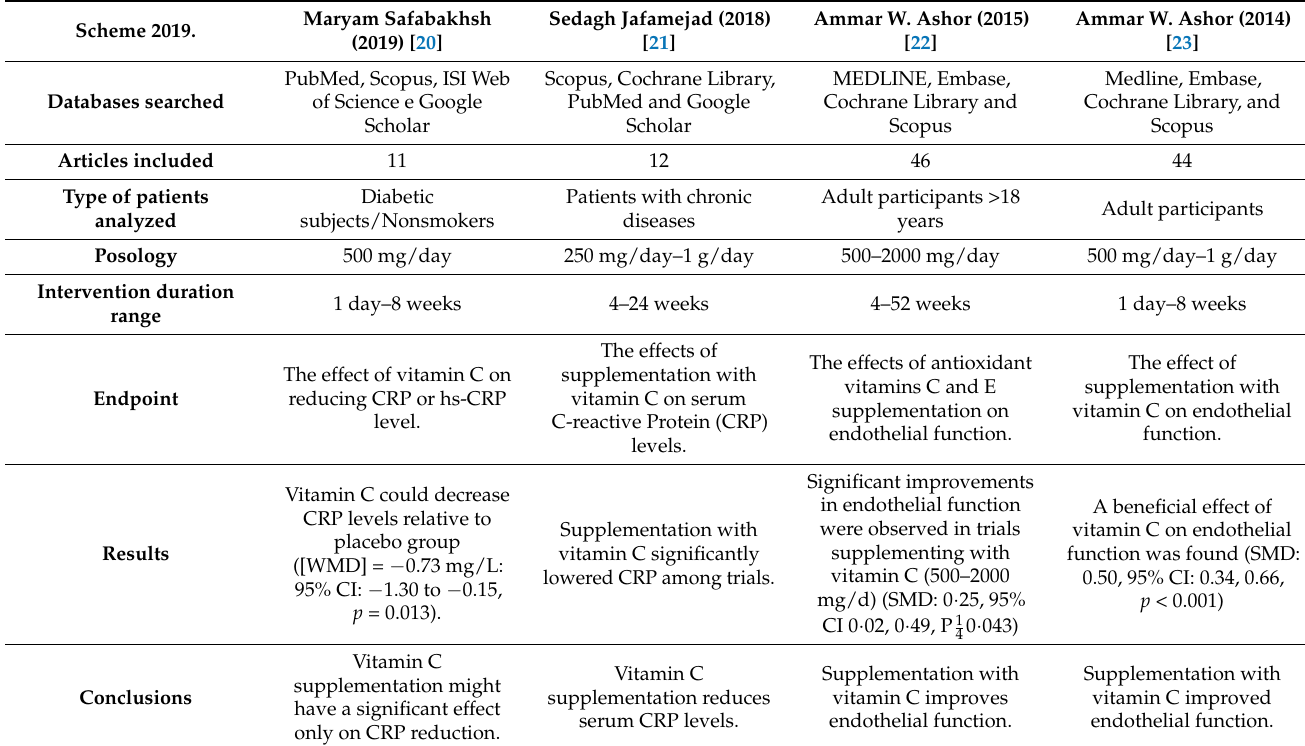
Table 3. Vitamin C: characteristics of the included systematic